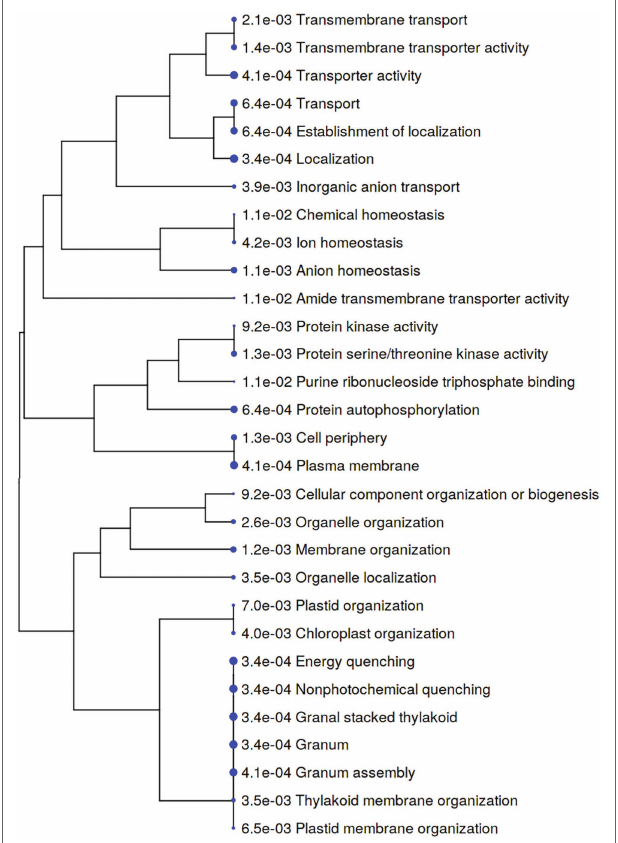
FIGURE 7 | A hierarchical clustering tree summarizing the correlation among significant pathways of the increased differently abundant phosphoproteins in Iwa (value of p < 0.05, log 2 fold change > 2). Pathways with several shared genes are clustered together. Bigger dots (blue dots) indicate more significant p